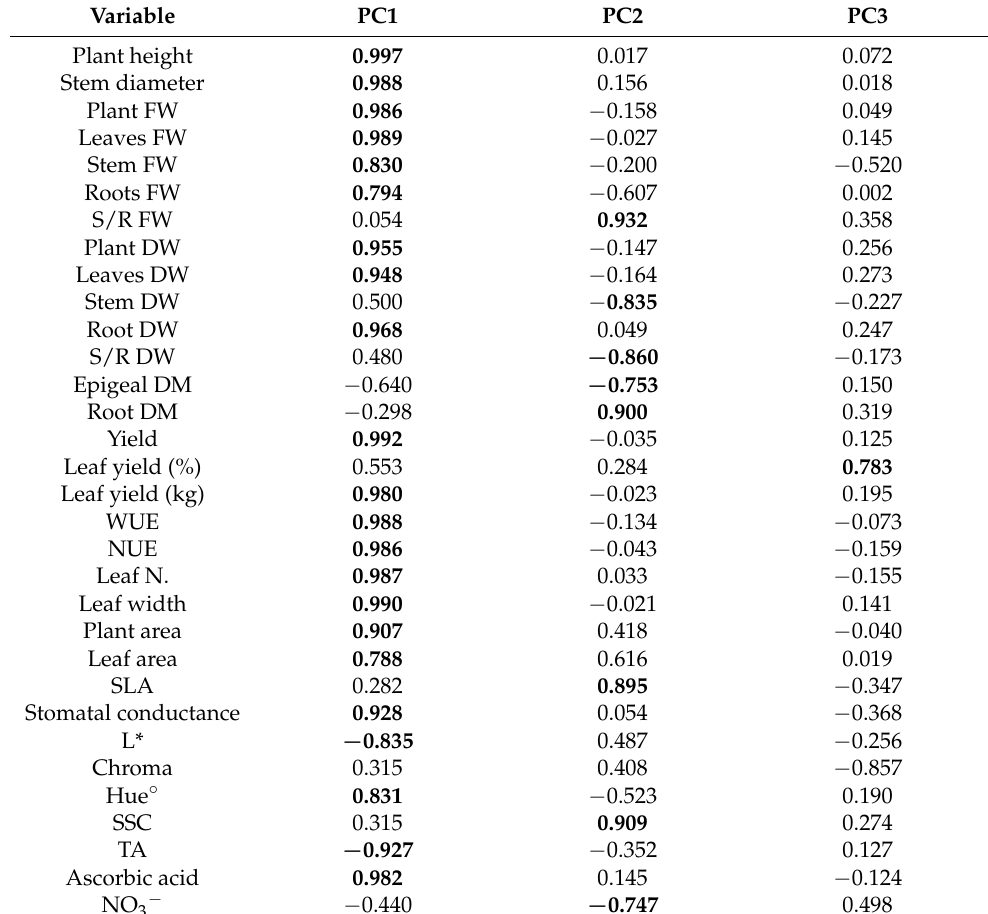
Table 5. Correlation of variables to the factors of the principal components analysis (PCA) based on the agronomic and quality characteristics of leaf lettuce at